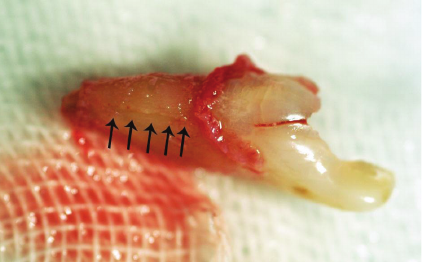
Figure 1: Preoperative photograph; arrows showing the crack line on the facial surface of left maxillary central incisor.